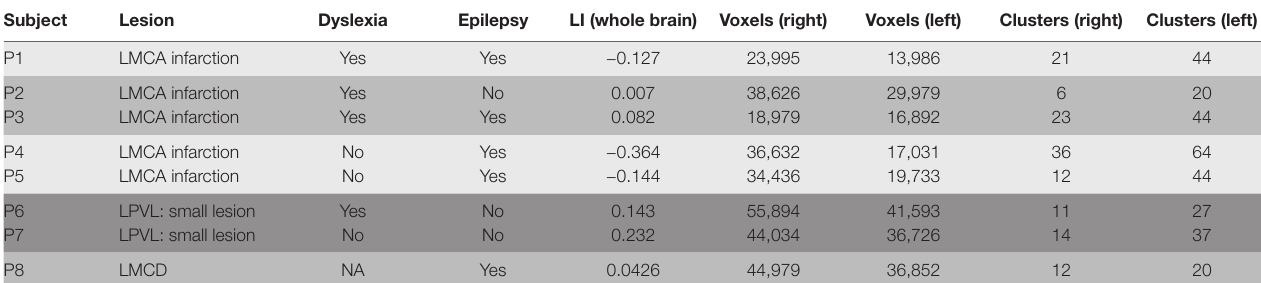
TABlE 3 | Activation in right and left hemisphere during the language task (WG).